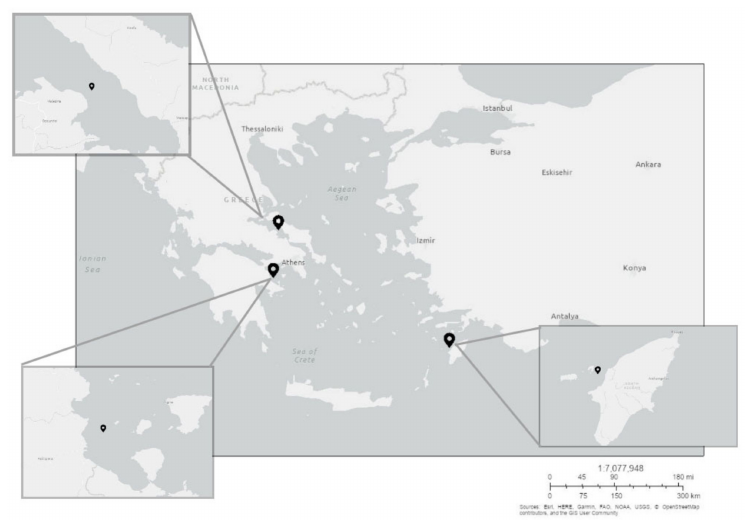
Figure 1. Locations of the three farms that are part of the IMTA trials. Aq1 is located in the area of Epidaurus in Saronikos Gulf, Aq2) is located in the Evoikos Gulf, and Aq3 is in the west of